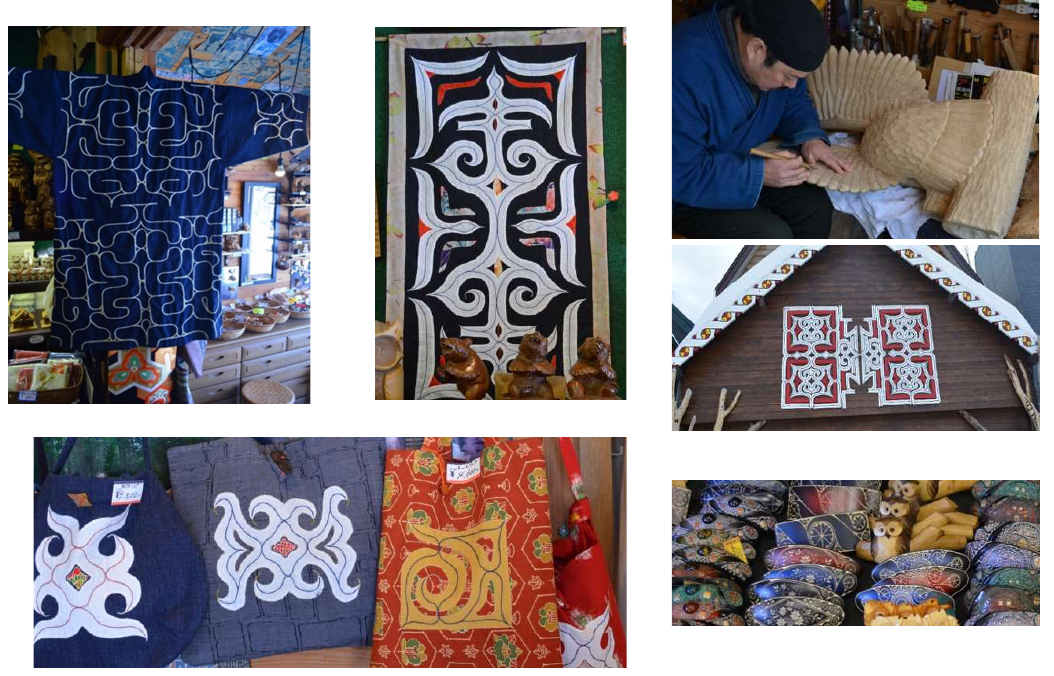
Figure 8. Some glimpses of Ainu motifs.